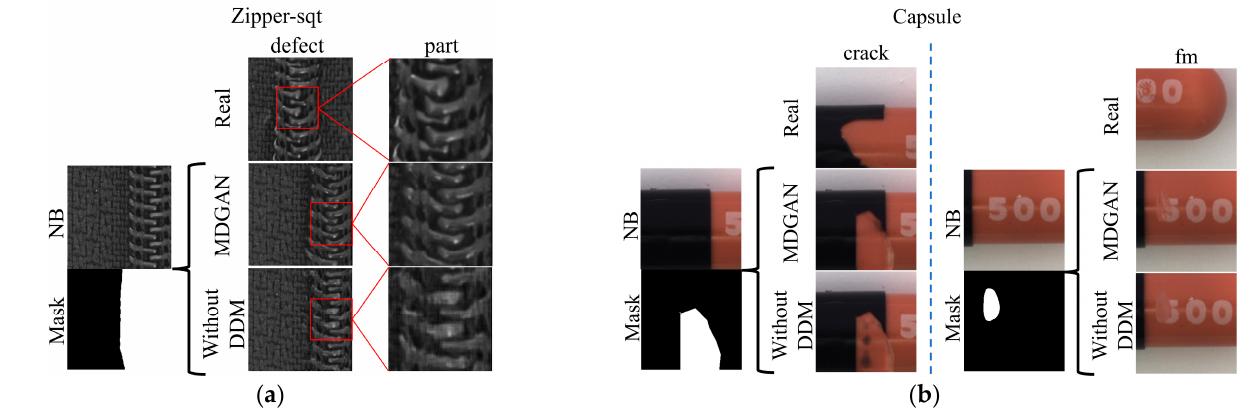
Figure 8. Comparison of with and without DDM. Real is the real defect image. MDGAN and Without DDM are the generated defect samples with and without DDM, respectively. ( a ) One type of effect without DDM. part is the enlarged defect in the red box of the defect . ( b ) Another effect.